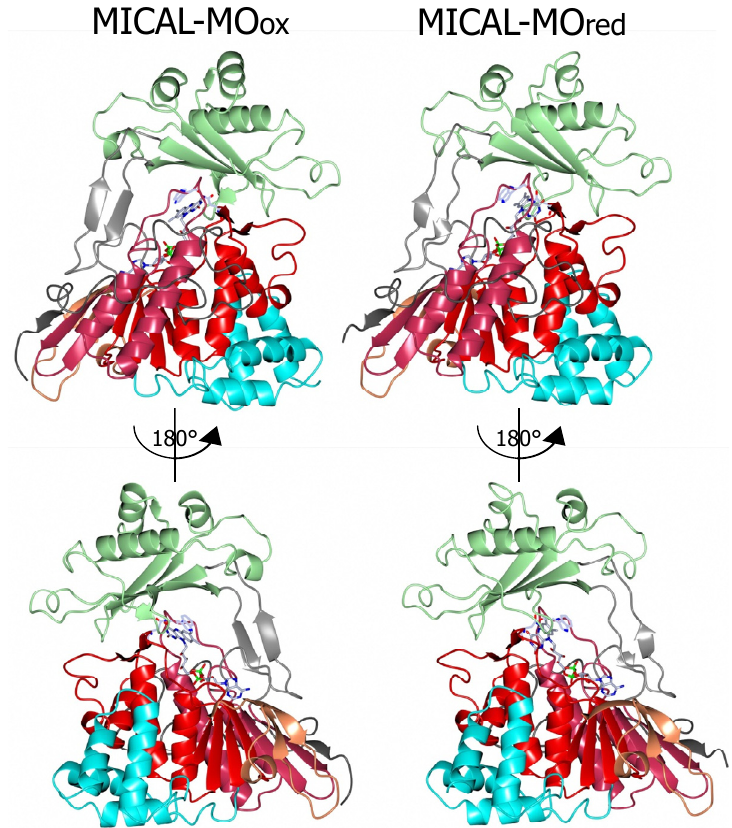
Figure 6. Comparison of the structures of MICAL1 monooxygenase domain. The structures of the “as isolated” mouse MICAL1 monooxygenase domain in the oxidized (“flavin out”) state (2BRY, chain A, MICAL-MO ) and of the NADPH-reduced (“flavin ox in”) species (2C4C, chain A, MICAL-MO ) as determined by Siebold et al . [3] are shown red in two orientations. Color scheme is as follows: blue, residues 1–85; red, residues 86–177, 208–217; coral, 178–208; grey, 218–237 ( β 9) and 366–375 ( β 15); green, 238–365; dark red, 376–442; dark grey, 443–489. FAD, Trp400 and Asn123 are shown in sticks with carbon in light grey, nitrogen in blue, oxygen atom in red and phosphorus in green. The CCP4MG program was used to generate the figure